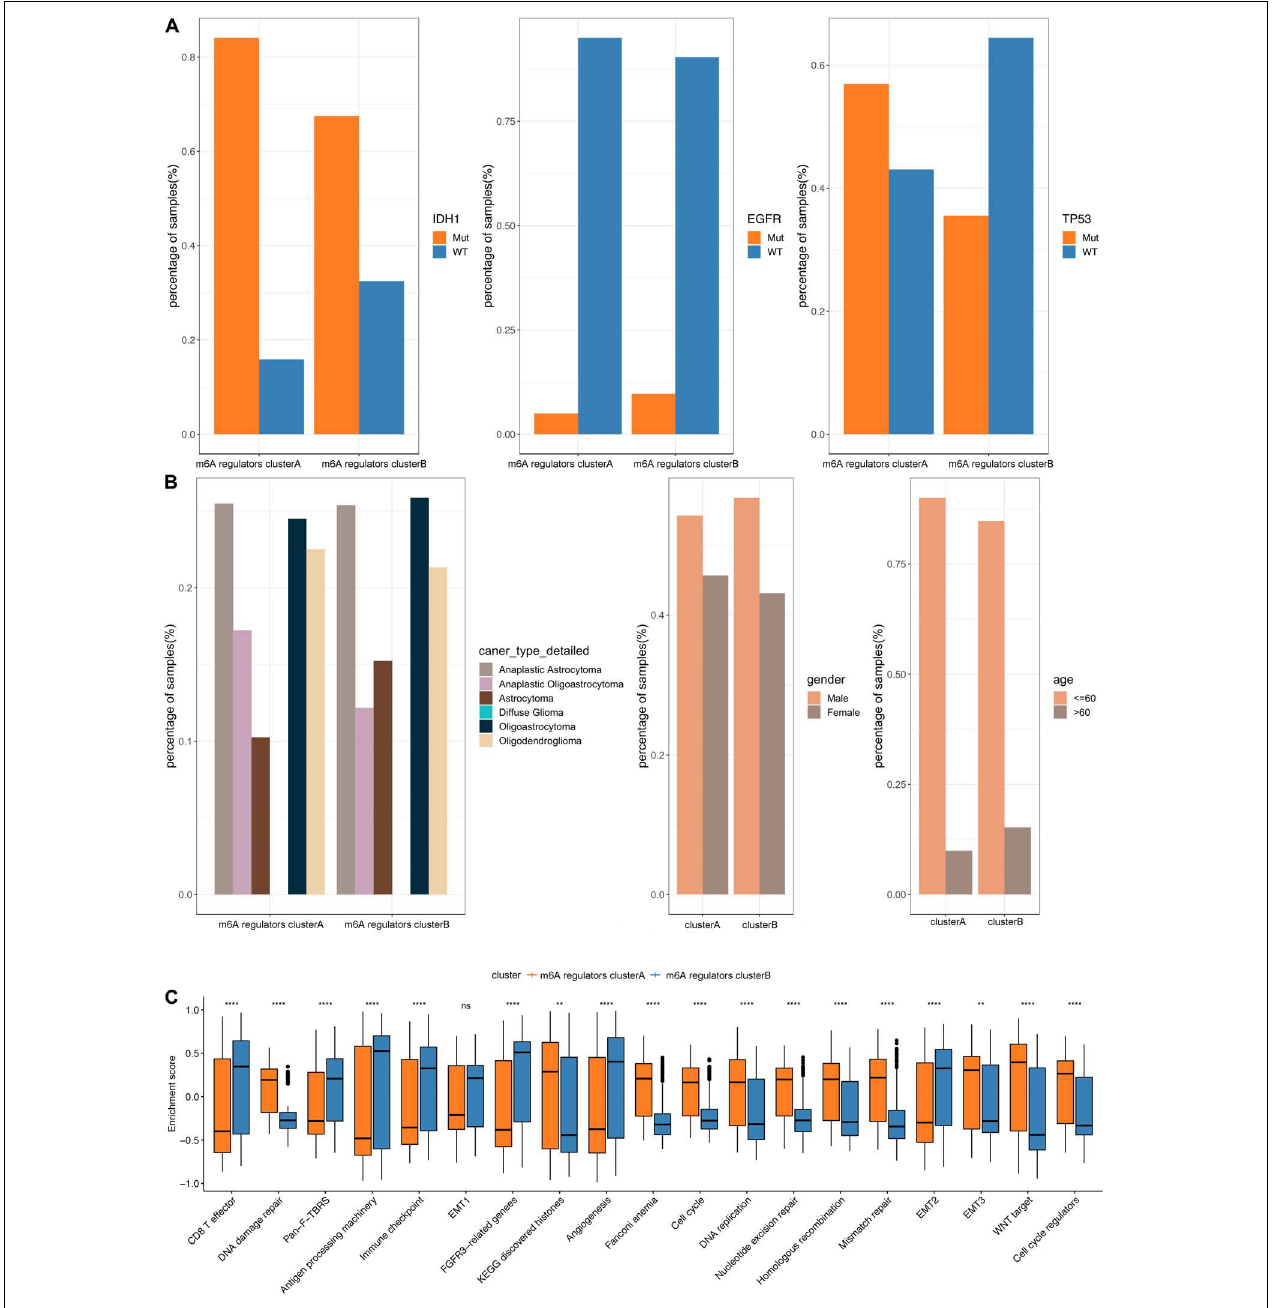
FIGURE 3 | Comparative analysis between m6A 4 regulators cluster in the TCGA dataset. (A) The distribution of IDH1, EGFR, TP53 mutations in the 2 m6A regulators clusters. (B) The distribution of cancer type, gender, and age in m6A regulators cluster. (C) The enrichment scores of different m6A regulators cluster groups difference (** p < 0.05, **** p <